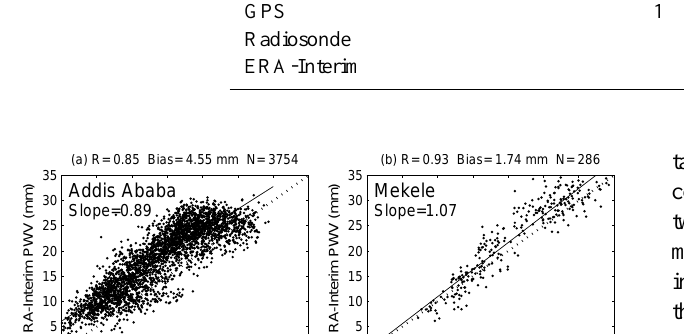
Table 4. Correlation, and enclosed within the bracket are bias (left) and RMSD (right) of PWV between different observations. The sign of the bias is chosen in a way that implies the bias of the first column with respect to the first row. Corr FTIR GPS Radiosonde ERA-Interim (bias (mm), RMSD (mm)) FTIR 1 0.92 ( − 0.6,1.6) Radiosonde